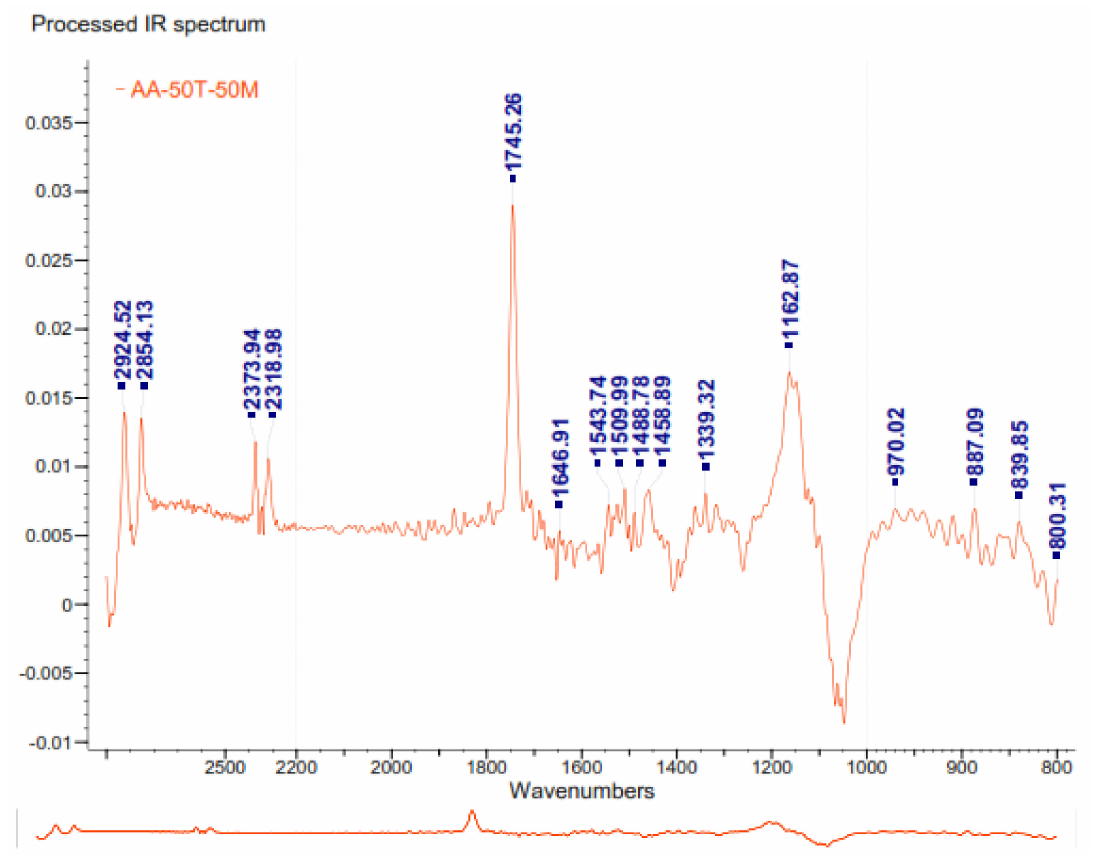
Figure A3. FTIR of sample AA-50T-50M. Table A3. Analysis of FTIR result for sample